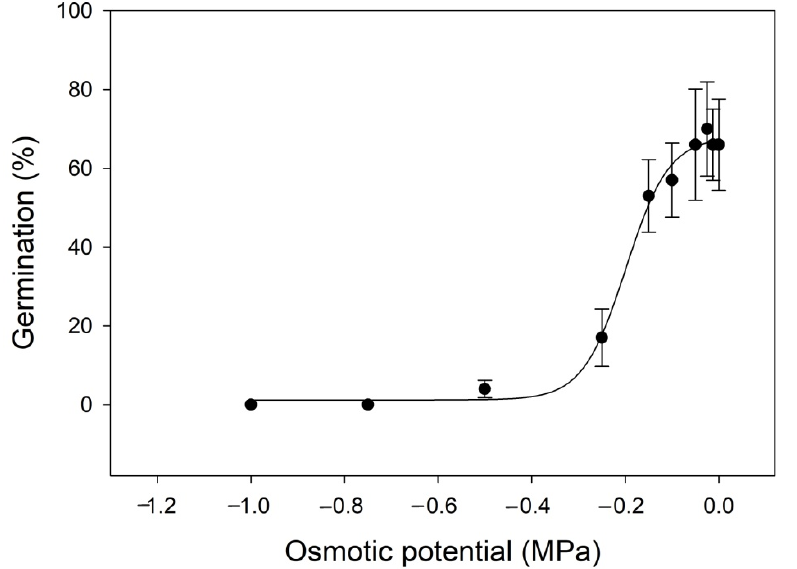
Figure 3. White clover seed germination over time at various osmotic potentials (MPa). Data were regressed with the following equation: G = G max /{1 + exp[ − (x − x 0 )/ b ]}. Equation was G = 67.74/{1 + exp[ − (x − 0.1997)/ − 0.0469]}, standard errors for G max , x 0 , b measured 4.56, 0.0174, and 0.0144, respectively, R 2 = 0.79, and p < 0.0001. Results were pooled over two experimental runs. Vertical bars represent standard errors ( n = 8). Abbreviation: WAP = weeks after planting.